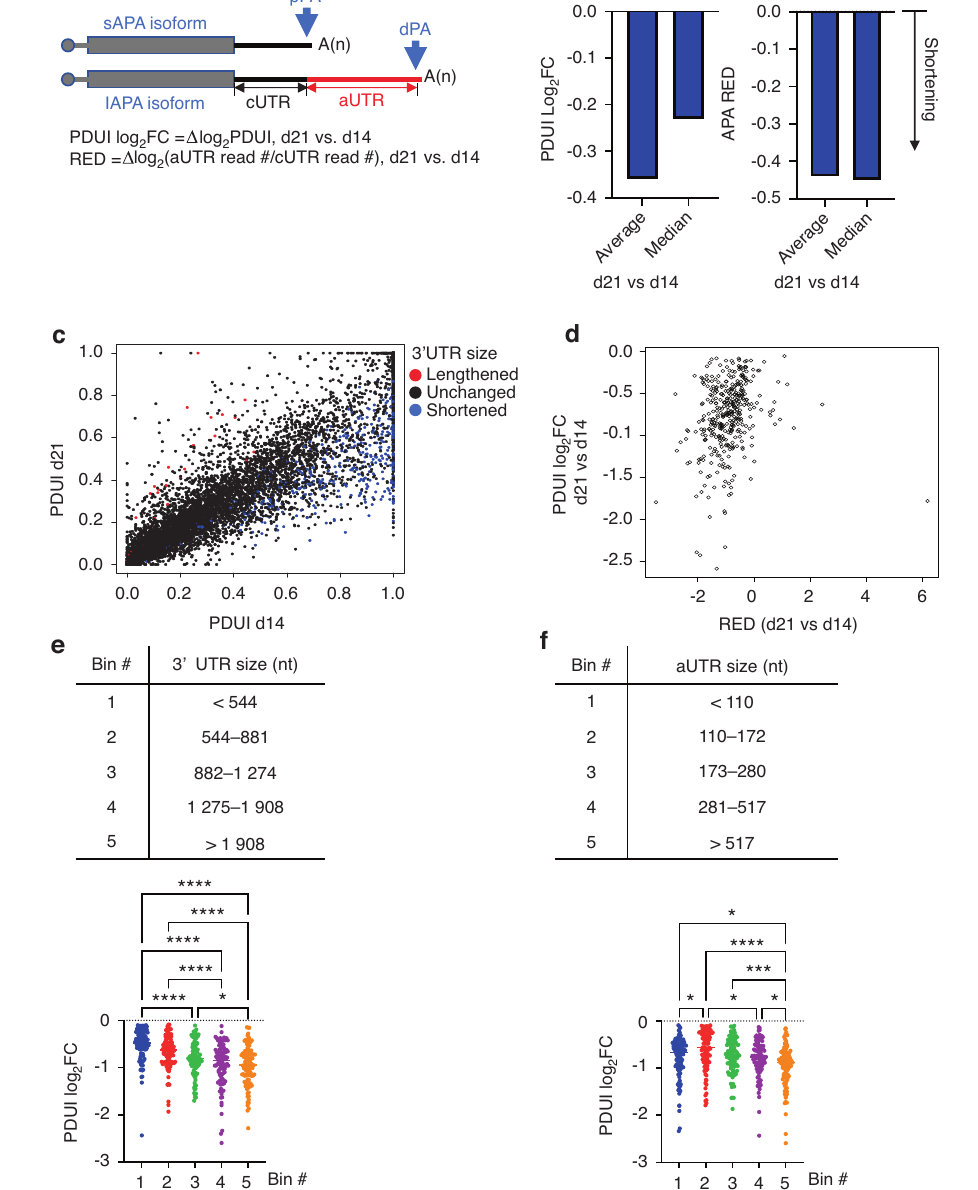
Fig. 6 Prevalent 3 ′ UTR shortening accompanies endochondral ossi fi cation. a General schematic presentation of APA isoforms showing representative proximal and distal PAs (pPA and dPA, respectively). PDUI Log 2 FC and RED values were calculated by InPAS and APAlyzer, respectively, as indicated. b Average and median PDUI log 2 FC (left) and RED (right) values were calculated by InPAS and APAlyzer, respectively, for all the analyzed genes (Tables S4 and S5). The negative average and median values indicate a global trend of 3 ′ UTR shortening on d21 relative to d14. c A scatter plot showing changes in 3 ′ UTR length on d21 compared to d14. Each dot represents a gene, and signi fi cantly lengthened or shortened 3 ′ UTRs are shown in red and blue, respectively. Signi fi cance was de fi ned as a P adj < 0.05 and >20% change in the expression ratio of the 2 APA isoforms. d Correlation between InPAS-generated PDUI log 2 FC and APAlyzer-generated RED values for genes that exhibited signi fi cant 3 ′ UTR shortening on d21 relative to d14 (shown in blue in “ c ” ). e (Top): Genes that exhibited signi fi cant 3 ′ UTR shortening were categorized into 5 similarly sized bins based on their 3 ′ UTR length. (bottom): scatter plot showing the relationship between 3 ′ UTR length and the extent of 3 ′ UTR shortening (presented as PDUI log 2 FC). Each dot represents a gene. The data are presented as the average ± SEM. f As in e except that the genes were categorized based on their aUTR length. * P < 0.05; *** P < 0.001, **** P < 0.000 1 using one- way ANOVA followed by Tukey ’ s post hoc